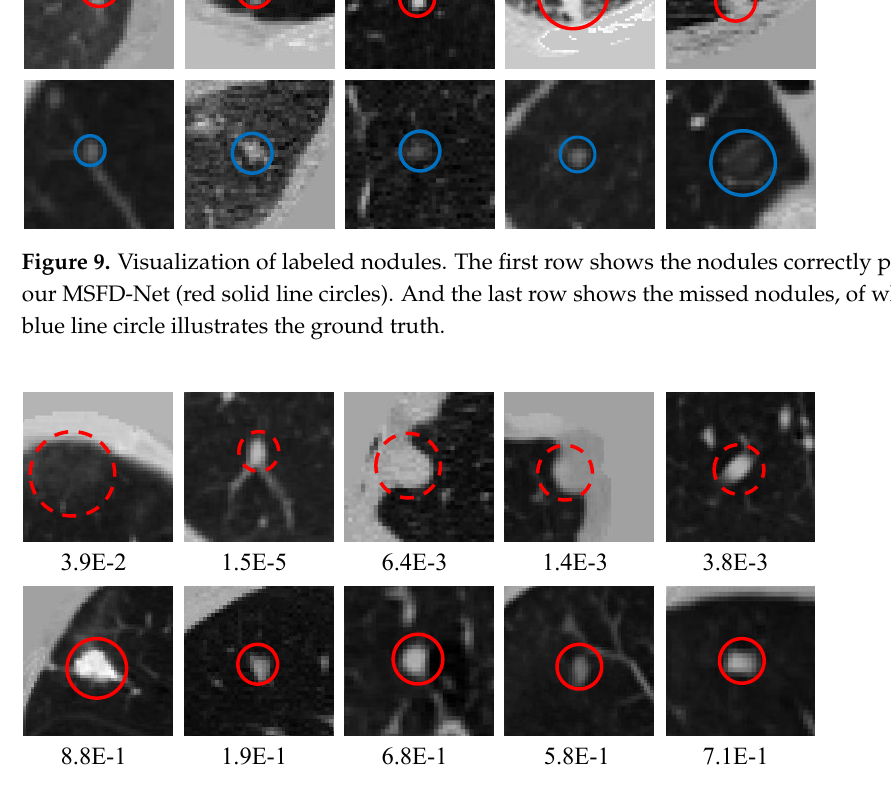
Figure 10. Visualization of candidates generated by the MSFD-Net. The red dotted circles indicate false positives and the red solid line circles are for true positives. Besides, the numeric note under each slice means the score estimated by